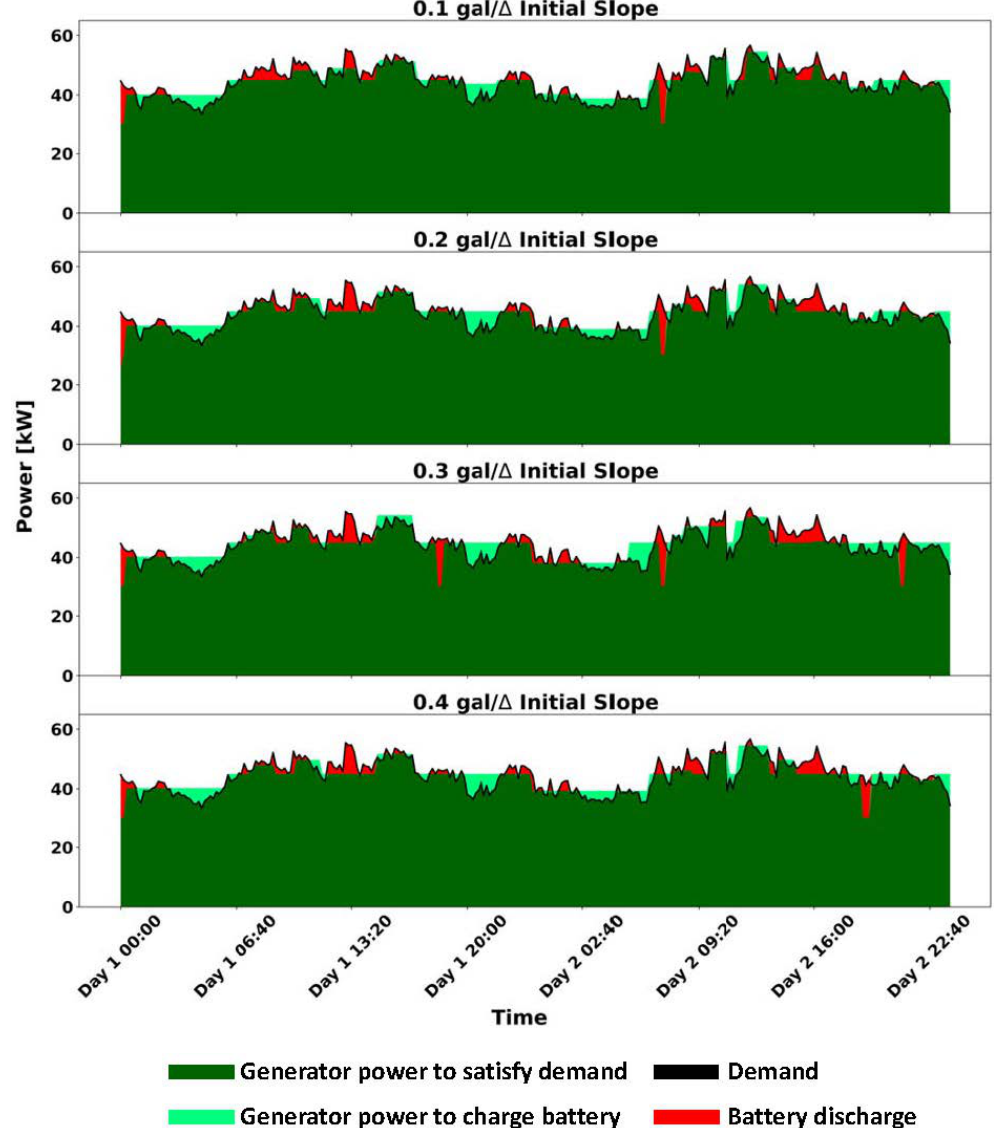
Figure 9. Power output plot based on piecewise linear penalty coefficients imposed on the generator for the summer demand